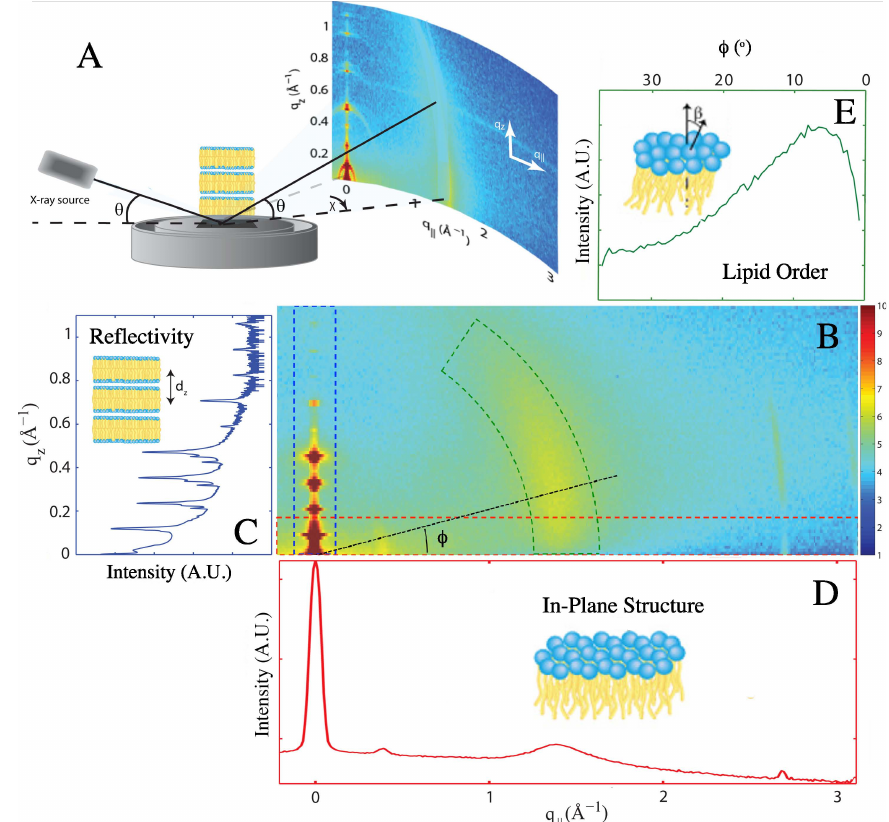
Extraction of one-dimensional scattering data from the 2D X-ray diffraction